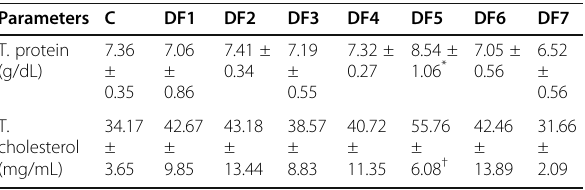
Table 9 Effect of chromatographic fractions of Waltheria indica Linn . root on testicular protein and cholesterol of male Wistar rats (Mean ± SD, n = 5 for each